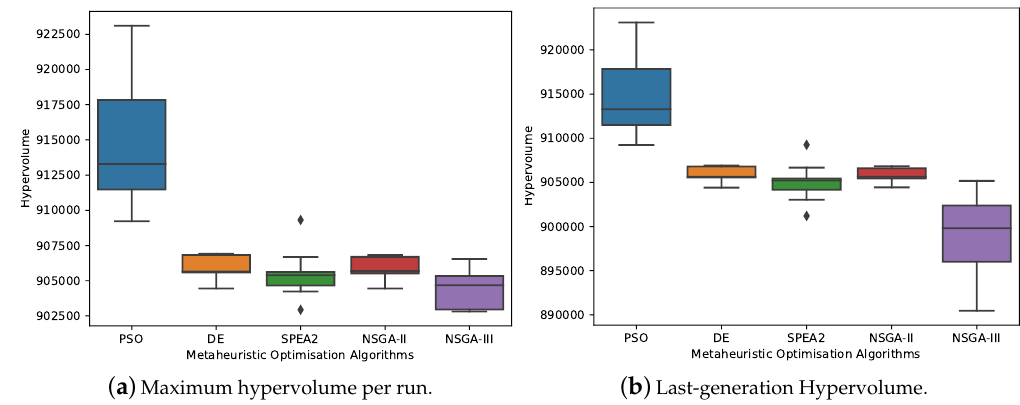
Figure 8. Distribution of the hypervolume metric for 10 independent runs of all multi-objective optimisation